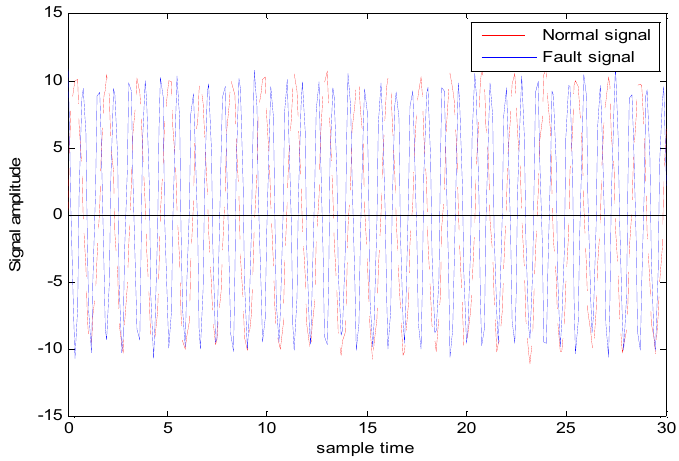
Figure 14. Normal and fault signals with the same amplitudes and different frequencies.